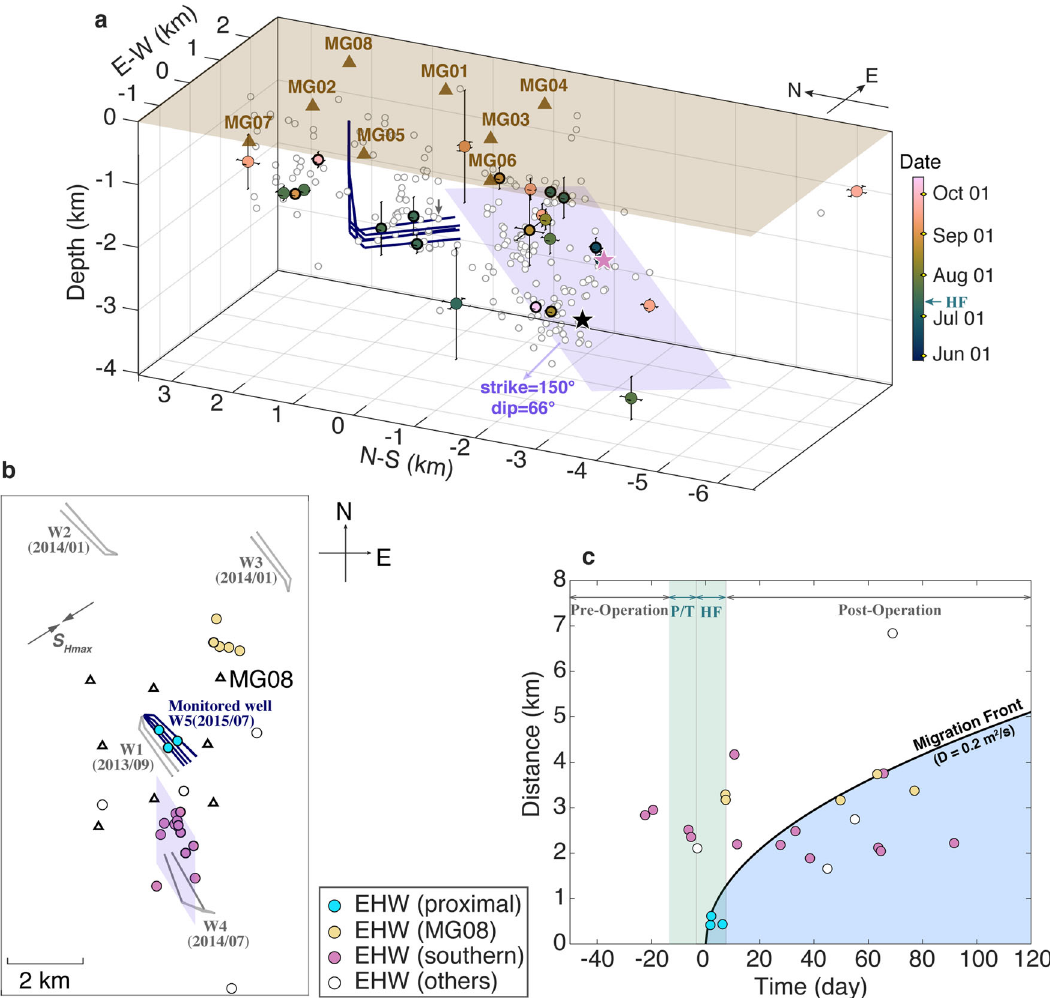
Fig. 2 Distribution of EHWs. a Spatial distribution of EHWs. Dots: 25 relocated EHWs. Dot color refers to the origin time. Black/Purple star: representative example of typical induced event/EHW in Fig. 1b – e. Purple shaded plane: least-squares plane fi t of the southern EHW cluster. Thick blue lines: HF wells. Gray circles: 285 typical induced events near the wellbore 24 . b Locations of three EHW clusters in map view, the well pads and horizontal well trajectories of the monitored well (W5, blue lines) and four nearby wells (W1 – W4; gray lines) of HF injections during 2013 – 2015. c Migration of EHWs. Parabolic envelopes: the “ diffusion front ” calculated using diffusivity values of 0.2 m 2 /s. The reference time ( t = 0) here is 13 July 2015, 10:52:22 (origin time of the fi rst near-well event following the injection 24 , marked in a with a small gray arrow). Blue shaded areas: EHWs following the migration pattern. Green shaded areas: preparation/pressure testing (P/T) and hydraulic fracturing (HF)